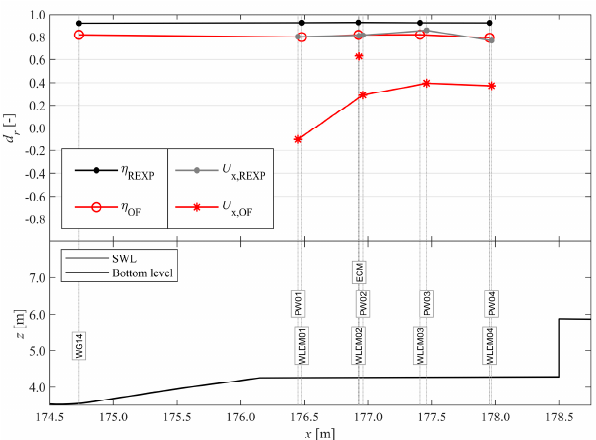
Figure 11. Index d r of REXP and OF with EXP from the dike toe up to the vertical wall. From top to bottom: d r for η and U x , and finally an overview of the sensor locations, SWL , and bottom profile.